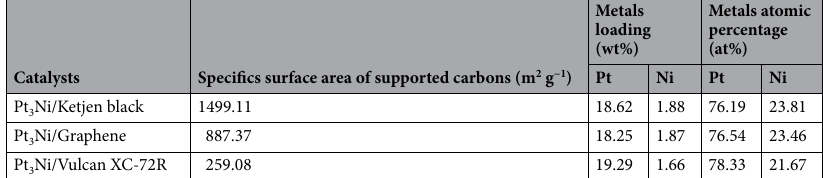
Table 1. Specifics surface area of carbon supports, metals loading and metals atomic percentage of the prepared Pt 3